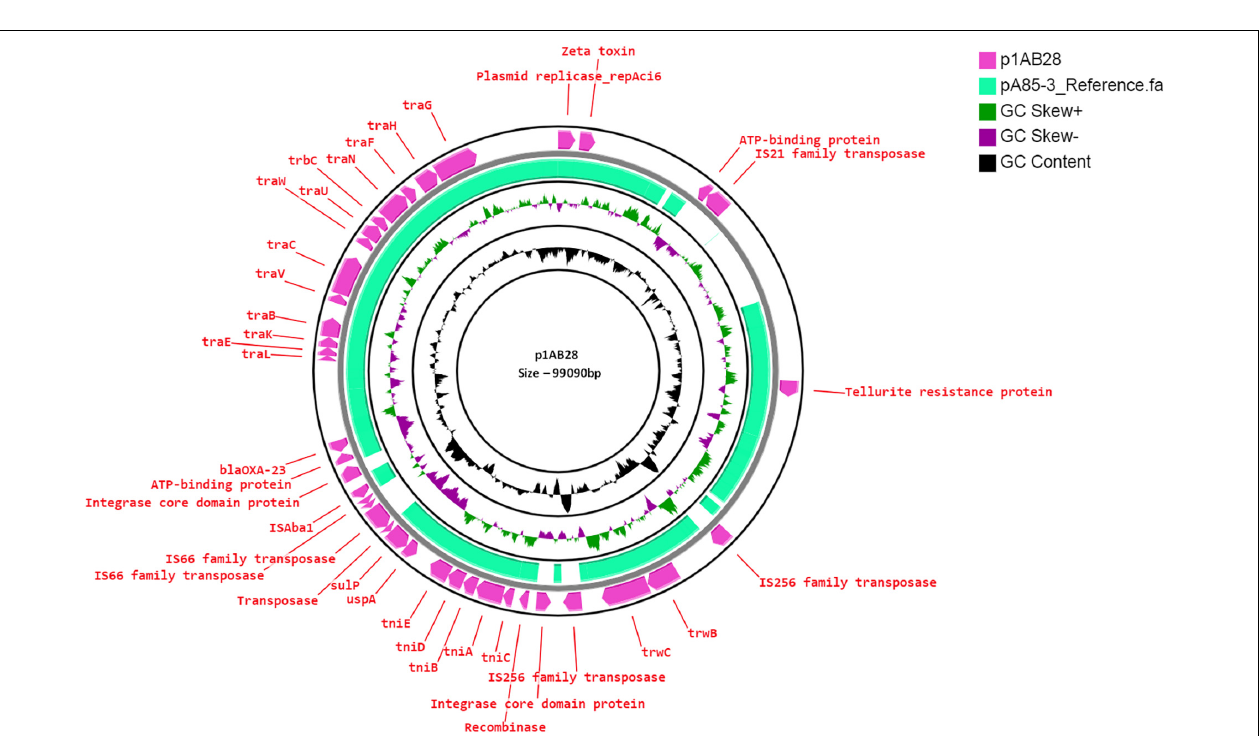
FIGURE 7 | Circular representation of rep Aci6 plasmid (pink arrow), p1AB28, of Acinetobacter baumannii displayed using CG view server with the reference plasmid pA85-3 (accession number–KJ493819) (green-colored region). The two inner circles represent GC content and GC skew. The pink-colored arrow represents the presence of the OXA-23 gene along with the plasmid replication gene, repAci6, tra genes, and plasmid mobilization genes in